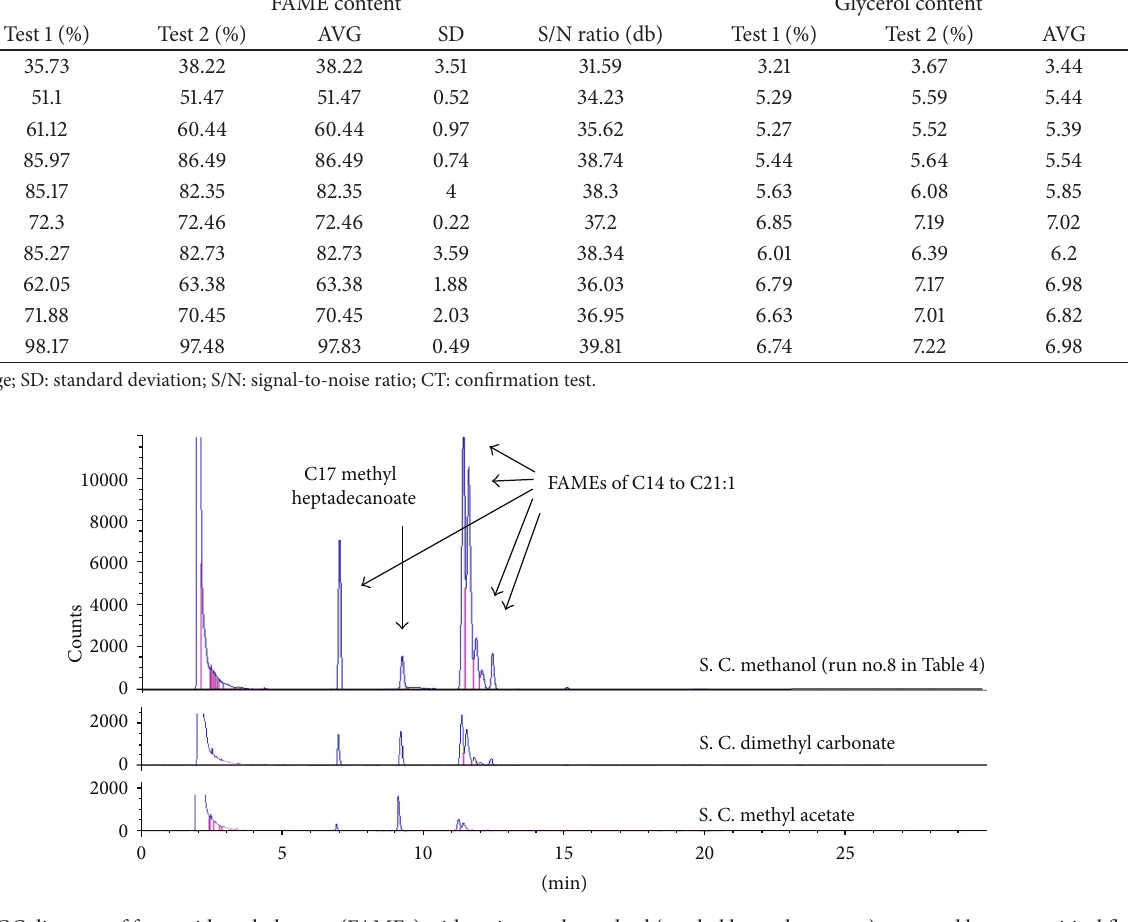
Figure 2: GC diagram of fatty acid methyl esters (FAMEs) with an internal standard (methyl heptadecanoate) prepared by supercritical fluid methods.